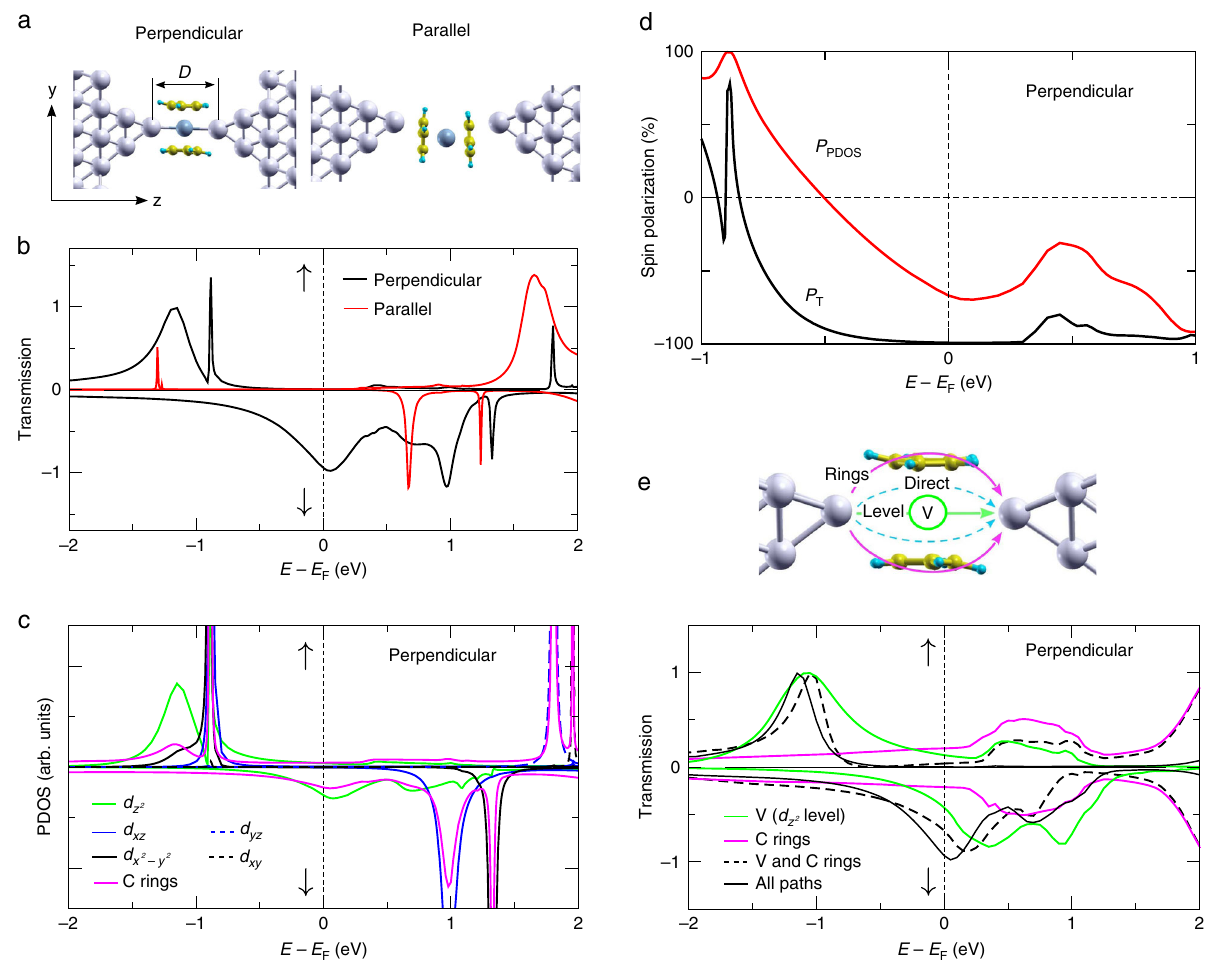
Fig. 4 Calculations for spin-polarized transport across Ag/vanadocene junctions. a Two junction con fi gurations characterized by perpendicular (left) and parallel (right) molecular orientation with respect to the junction axis. b Spin-resolved transmission versus energy for the two junction con fi gurations. c Spin-resolved projected density of states (PDOS) on the vanadium d orbitals for perpendicular molecular con fi guration (see also Supplementary Note 10). The PDOS on the rest of the molecule (two carbon rings) is shown in pink. The origin for the different widths of the spin-up and down transmission peaks is discussed in Supplementary Note 11. d Spin-polarization of transmission and vanadium d z 2 PDOS ( P T and P PDOS , respectively) for the perpendicular molecular con fi guration. Interestingly, P T remains rather high even at E < − 0.5 eV, where P PDOS is nulli fi ed and even changes its sign. e Spin-resolved transmission for different current pathways across the junction in the perpendicular molecular con fi guration. Two main transmission pathways — across the carbon rings (pink lines) and across the vanadium d z 2 level (green lines) — are found to play an essential role interfering destructively (constructively) at the Fermi level for spin-up (down) electrons, as seen by their overall contribution in black dashed lines. The black line describes all contributions (including direct silver-silver tunneling, for example). The origin for the shift in the transmission peaks is discussed in Supplementary Note